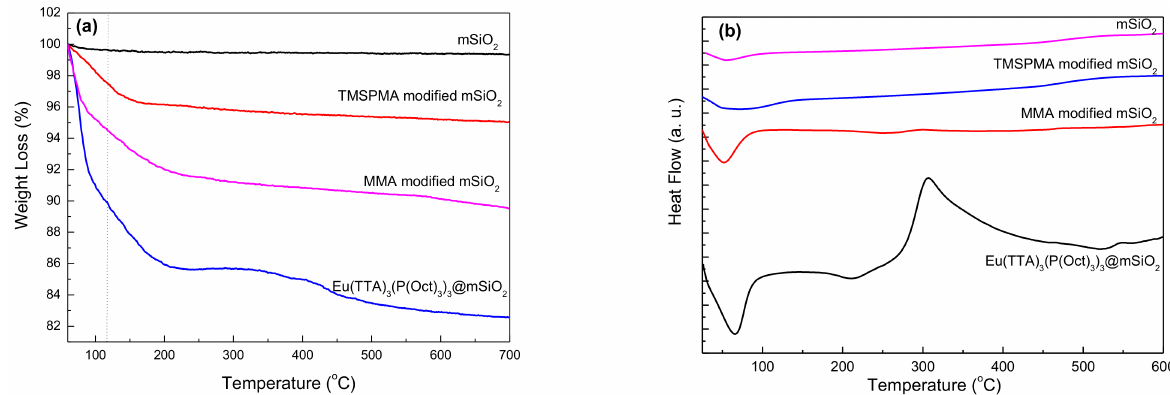
Figure 3. ( a ) Thermal gravimetric analysis (TGA) curves and ( b ) differential scanning calorimetry (DSC) thermograms of step-by-step modified samples for mSiO 2 , TMSPMA modified mSiO 2 (TMSPMA@mSiO 2 ), MMA modified mSiO 2 (MMA@mSiO 2 ) and Eu(TTA) 3 (P(Oct) 3 ) 3 @mSiO 2